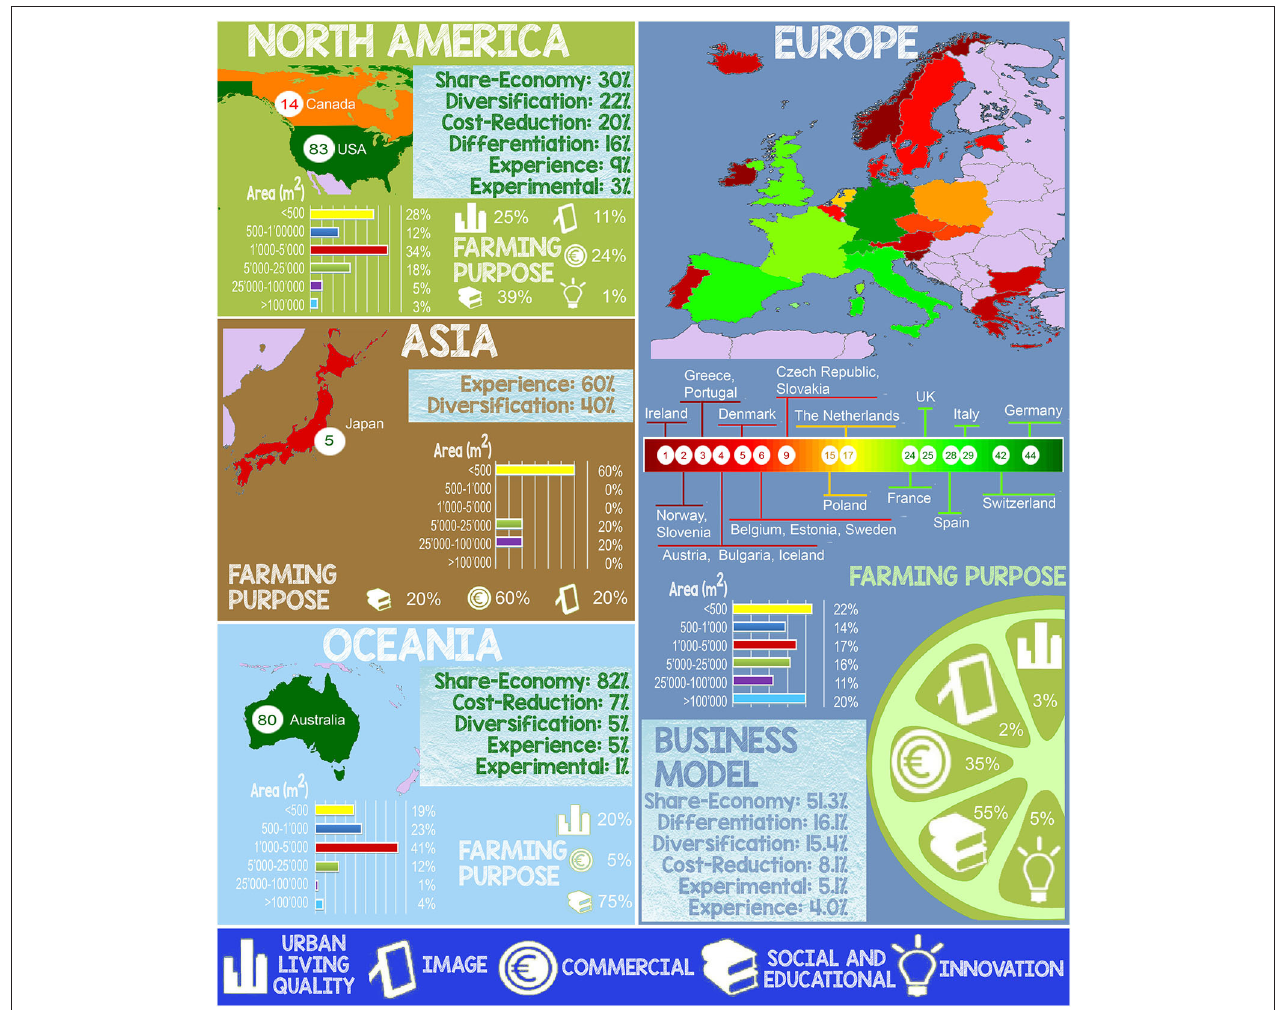
FIGURE 2 | Infographics on the inventory of UA projects in the Global North countries. In white circles the number of cases per country, also reflected within country color over the heatmap (e.g., red 0–10 projects per country, orange-yellow 10–20 projects per country, green more than 20 projects per country). In each World Region, figures on farm area, business model and farming purpose are integrated. Area charts represent the distribution frequency in the different size classes. Business models are classified according to Pölling et al. (2015) in the six categories: cost reduction, diversification, differentiation, share economy, experience, and experimental and placed in order of frequency. Farming purposes are classified accordingly to Thomaier et al. (2015) in five categories: urban living quality, image, commercial, social and educational, innovation. Sample composed of 417UA projects.